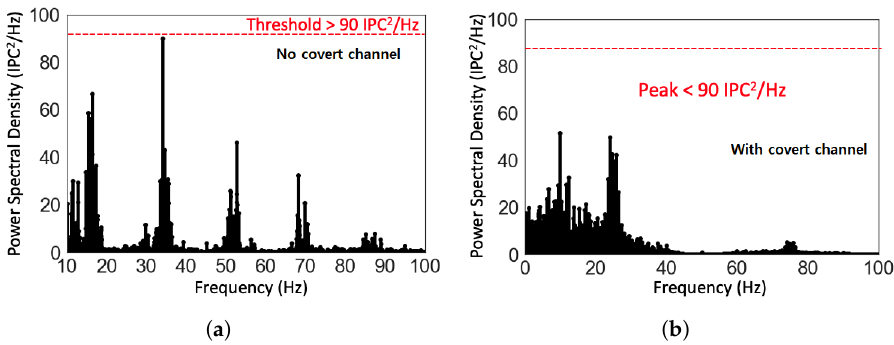
Figure 6. Power spectral density (PSD) of instructions per cycle (IPC) simulated during the execution of ( a ) random applications (sequentially) from SPLASH-2 and PARSEC benchmark suites on an Intel Haswell processor core (no covert channel) ( b ) a low power benchmark, raytrace, encoded with the secret data (i.e., with